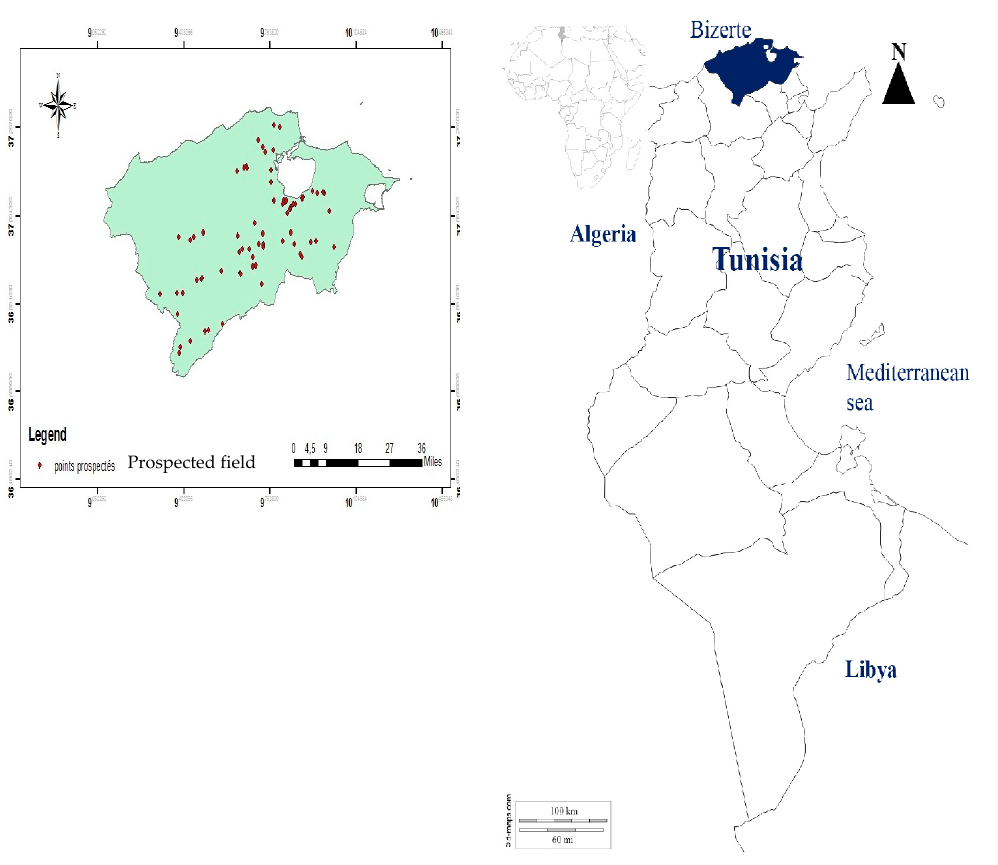
Figure 5. The investigated fields of durum wheat (Triticum turgidum L.) in Bizerte region in Northern Tunisia.